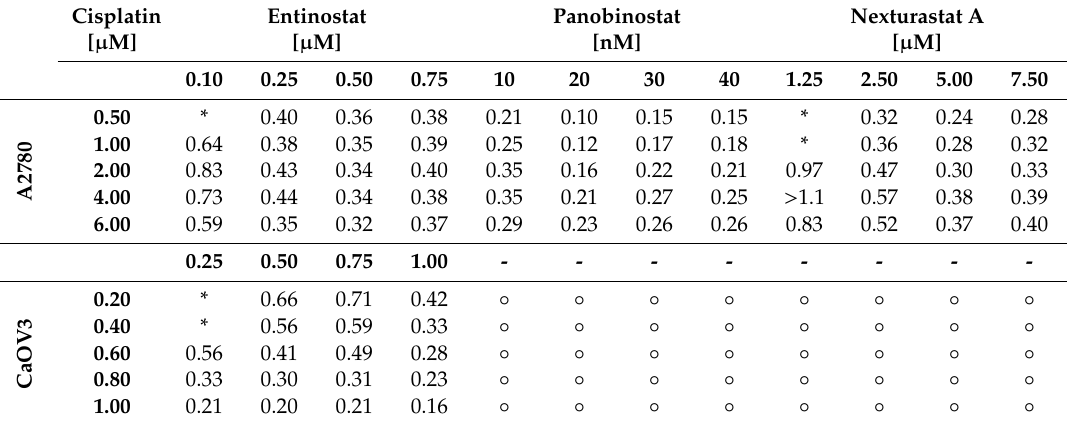
Table 7. Synergism studies (CI-values) between HDACi entinostat, panobinostat, or nexturastat A and